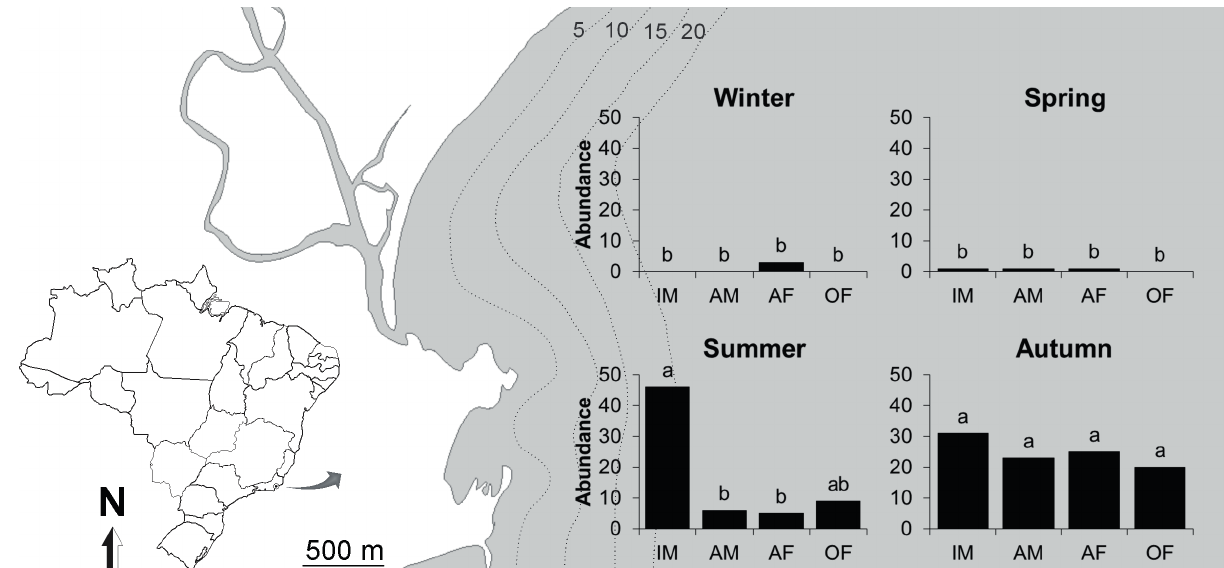
Figure 1 . Upwelling region off Macaé in southeastern Brazil, showing the seasonal abundance of demographic groups of the swimming crab Achelous spinimanus . IM = immatures, AM = adult males, AF = adult females, OF = ovigerous females. Different letters over bars denote significant differences among seasons and demographic